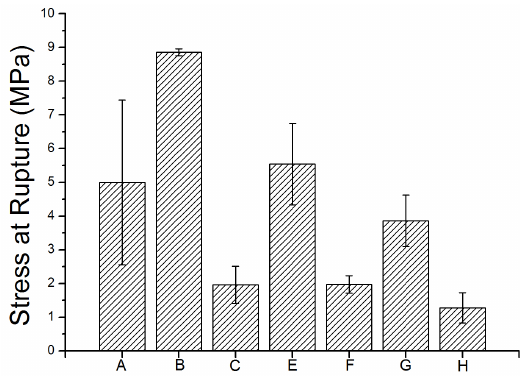
Fig. 3. Stress at rupture values for blends.